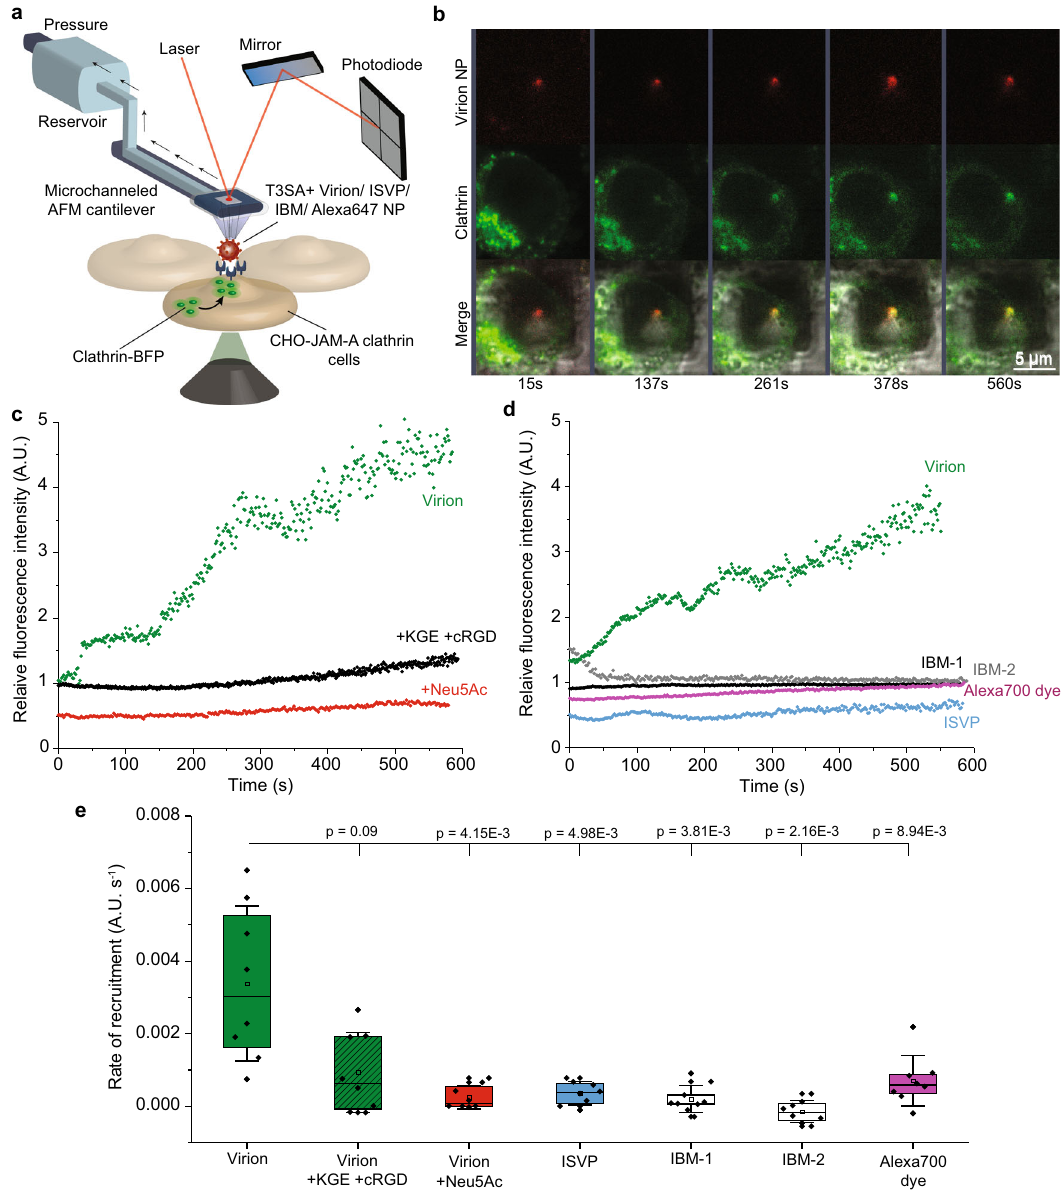
Fig. 6 Integrins function in clathrin recruitment by reovirus bound to cells. Integrin-induced recruitment of clathrin (labelled with blue fl uorescent protein [BFP]) at the plasma membrane following reovirus binding was quanti fi ed using Fluid-FM coupled with confocal microscopy. a Fluid-FM coupled to a confocal imaging setup. Fluorescent T3SA + reovirus particles covalently coupled to gold-coated nanoparticles were trapped using a micro-channeled cantilever and brought in contact with clathrin-BFP-expressing CHO-JAM-A cells. Fast-scanning confocal microscopy was used to simultaneously visualize reovirus and clathrin fl uorescence signals. b Representative time-lapse images from fl uid-FM/confocal imaging show recruitment of clathrin (BFP, for better visibility shown in green instead of blue) to a reovirus (Alexa 647, red) contact site. c Recruitment of clathrin observed over time using blue fl uorescence intensity around beads coated with T3SA + virions in the absence (green) or presence of integrin-blocking peptides KGE and cRGD (black) or Neu5Ac (red). d Recruitment of clathrin observed over time using blue fl uorescence intensity around beads coated with T3SA + virions (green) and control particles ISVP (blue), IBM-1 (black), IBM-2 (gray), or Alexa 700 dye (purple). Representative images from control experiments are displayed in Supplementary Figs. 6 and 7. e Box plot shows the rate of clathrin recruitment calculated from the quanti fi cation of fl uorescence over time (slopes of intensity vs. time curves fi t to linear regressions). The horizontal line within the box indicates the median, boundaries of the box indicate the 25th and 75th percentile, and whiskers indicate the highest and lowest values. An open square within each box indicates the mean. Error bars indicate s.d. of the mean value. All data are representative of N = 10 independent experiments. P values were determined by two-sample t -test using virus 30 , hantavirus 31 , and echovirus 32 , among others use integrins reovirus in structures of attachment proteins and receptors 14 and for entry. This underscores the importance of understanding the also undergoes integrin-mediated internalization 33 . The reovirus λ 2 protein contains conserved IBMs, RGD and KGE 21,34 , on mechanism of integrin interaction to gain insights into the initial steps in virus interaction with a host cell to establish infection. Of surface-exposed loops, which are well-positioned to interact with particular note is adenovirus, which shares similarities with integrin. While both reovirus virions and ISVPs contain these